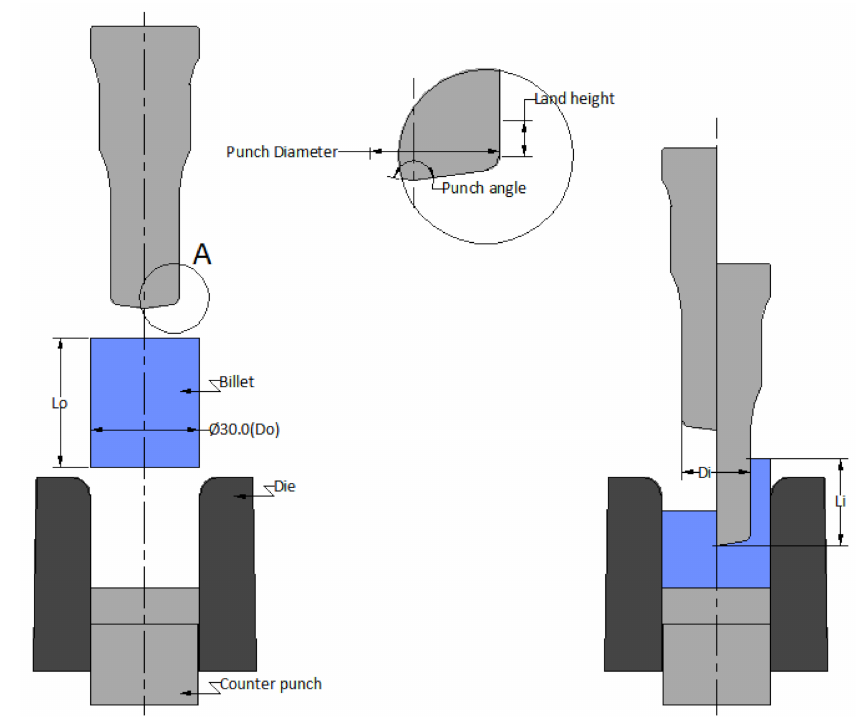
Figure 1. Cold forging backward extrusion process with punch, die, and billet details.